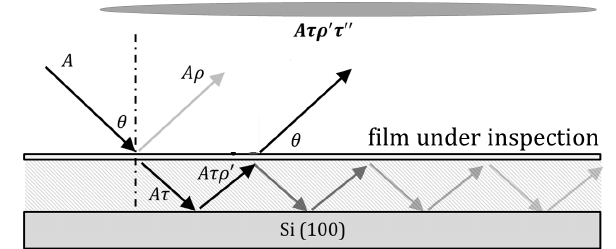
Figure 2. Two-layer interferometer and its